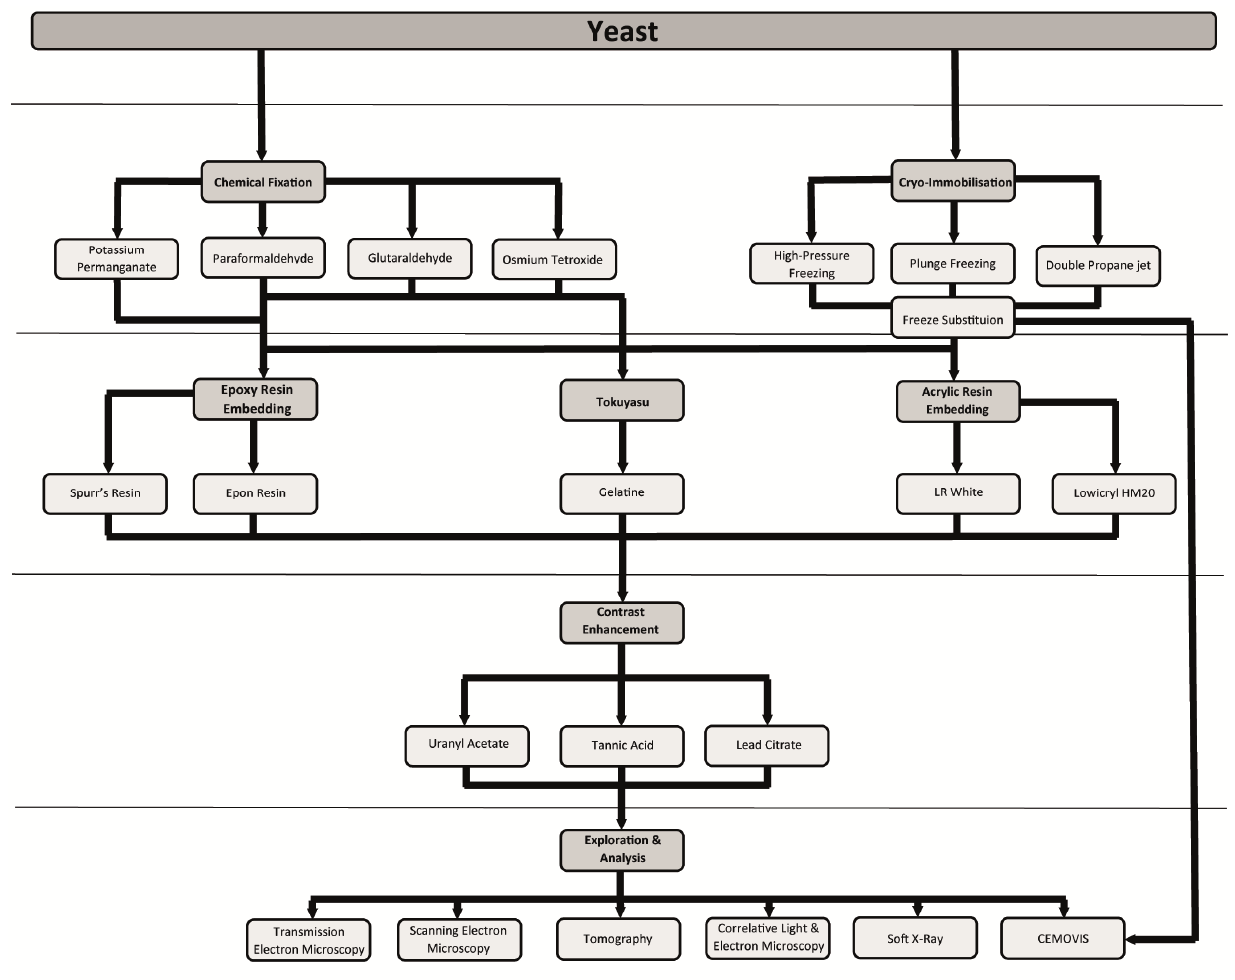
FIGURE 1: EM approaches to explore yeast ultrastructure and immunocytochemical localization of proteins. Schematic representation summarizing mainstream approaches for EM and IEM (immunoelectron microscopy) to explore the morphology and protein localization in